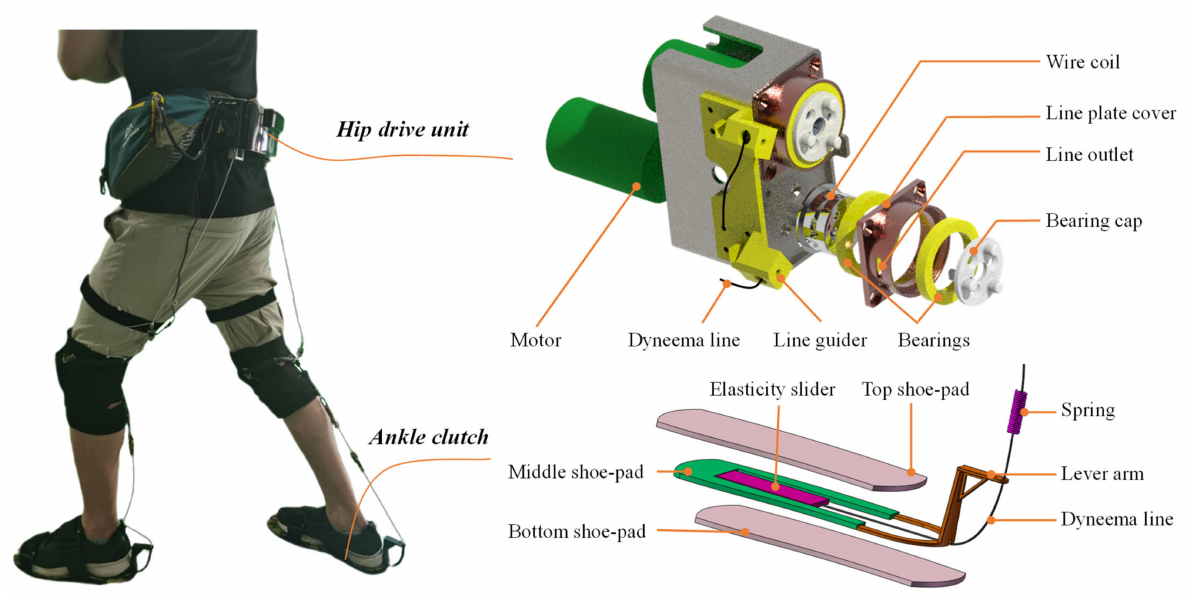
Figure 2. Detailed structure of the hip drive unit and passive ankle